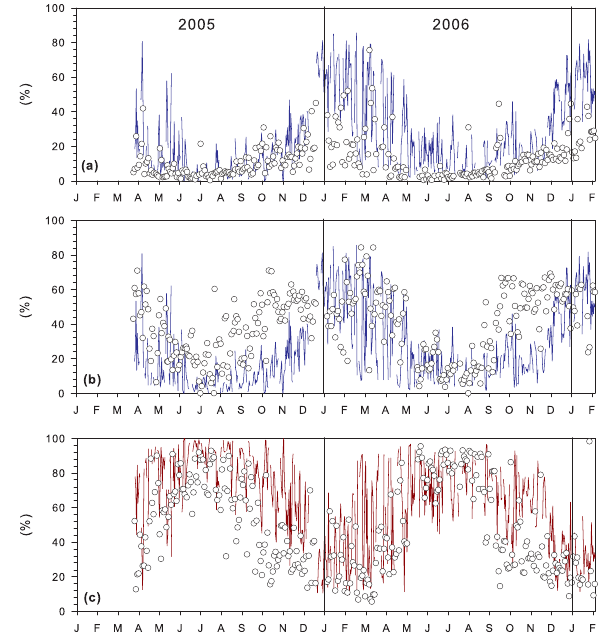
Fig. 7. Results of the thermodenuder experiments: portion of volatile (a) and semi-volatile (b) particles based on daily mean val- ues along with the portion of biogenic sulfur (i.e. the sum of nss- SO 2 − and MS concentrations, blue line) as well as refractory par- 4 ticles (c) along with the portion of sea salt aerosol (red line). The ionic concentrations were derived from daily aerosol samples taken during the same